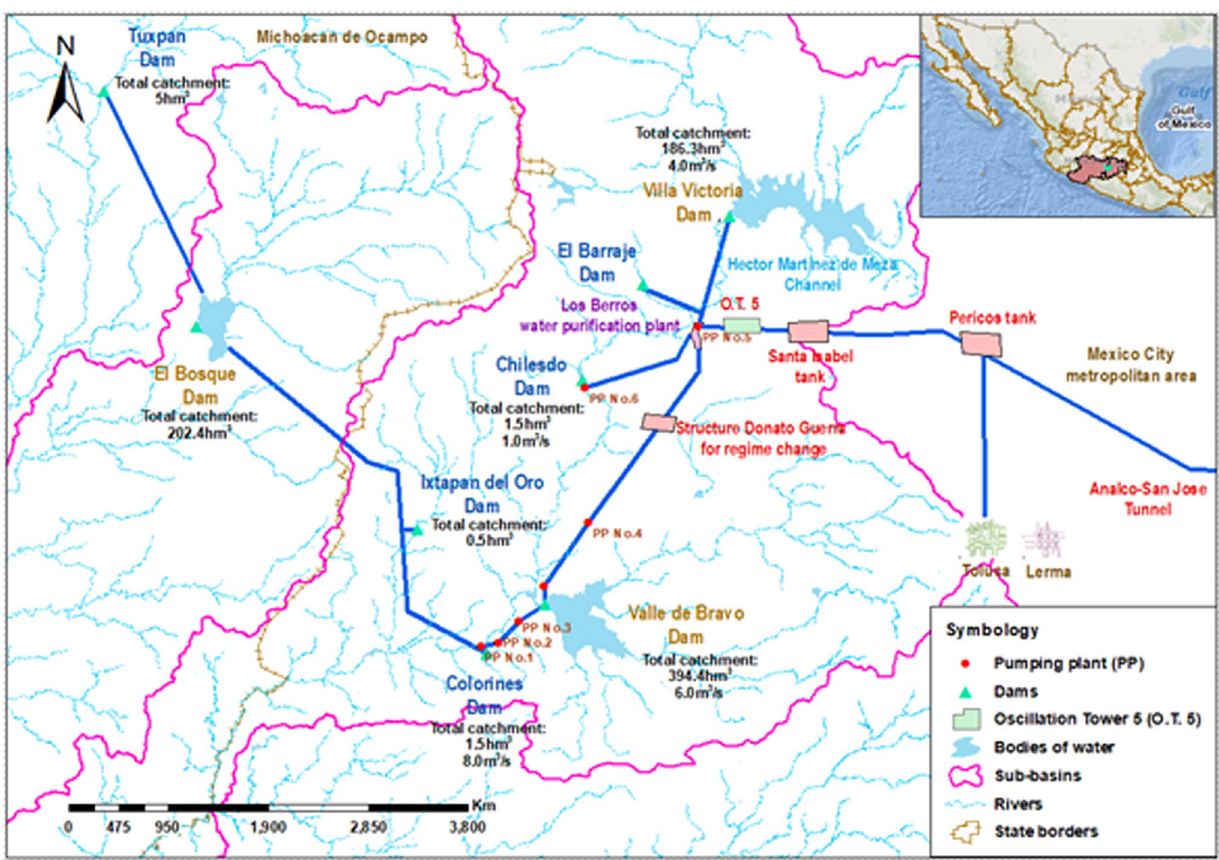
Fig. 1 Location of reservoirs, dams, and associated infrastructure of the Cutzamala